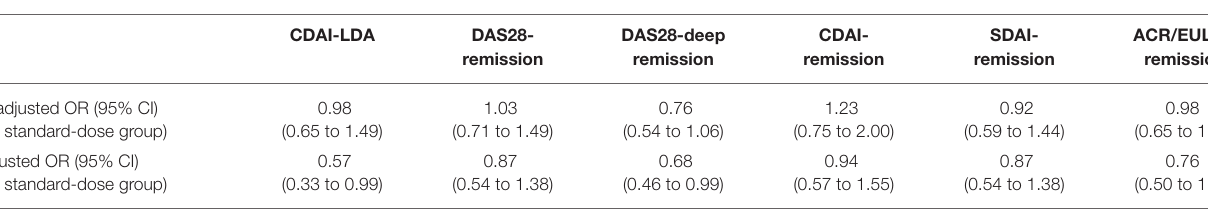
FIGURE 1 | Change in dose quotient (DQ) and the number of patients over time between the two groups. TABLE 3 | Effect of tapering tocilizumab on achieving